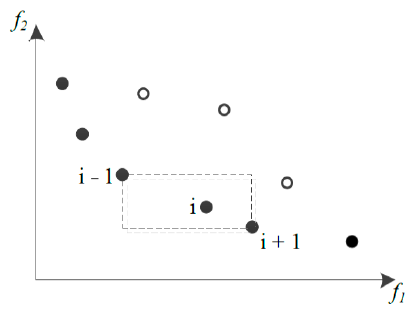
Figure 1. Crowding degree of individual i .